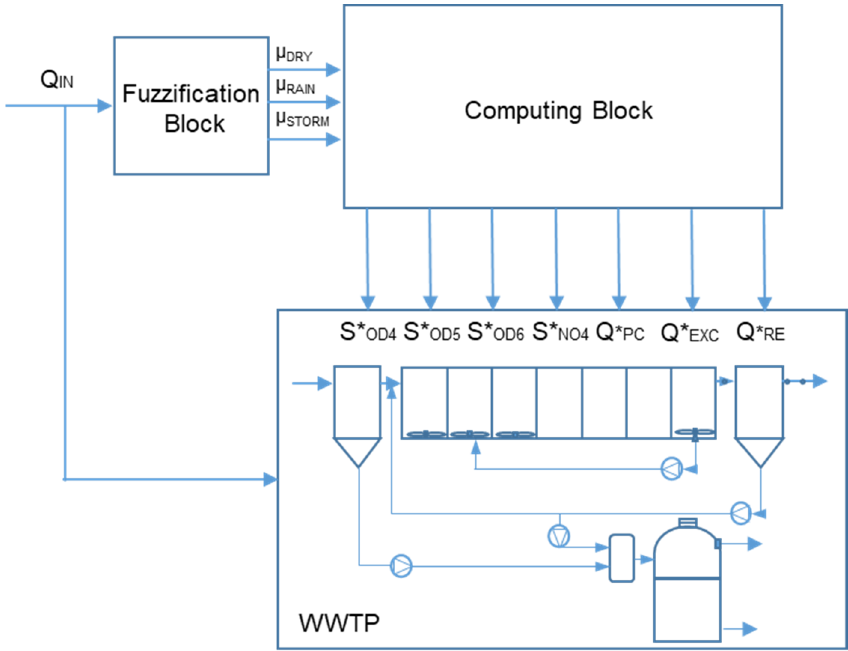
Figure 5. The proposed control strategy of the wastewater treatment plant.